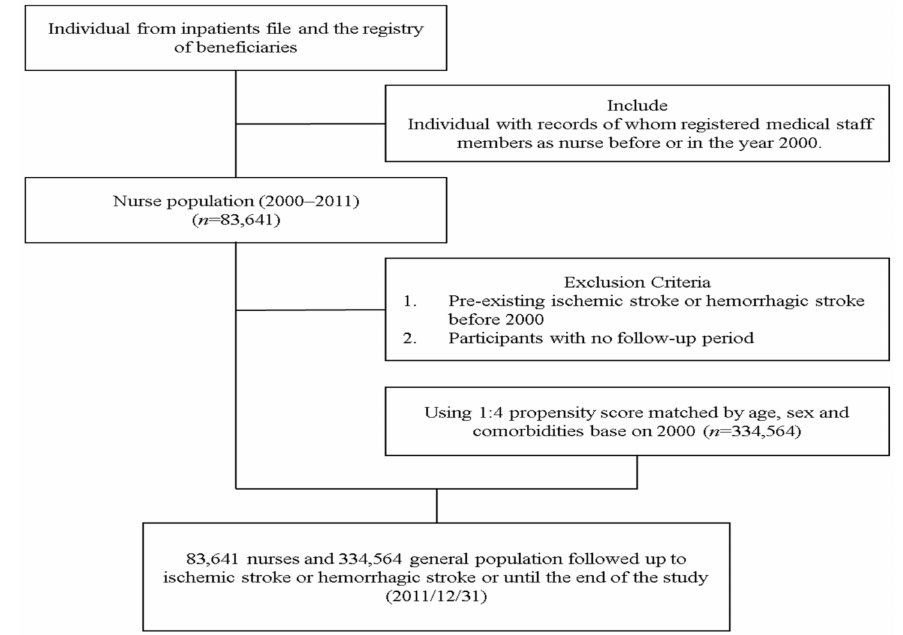
Figure 1. Flowchart for the selection of study